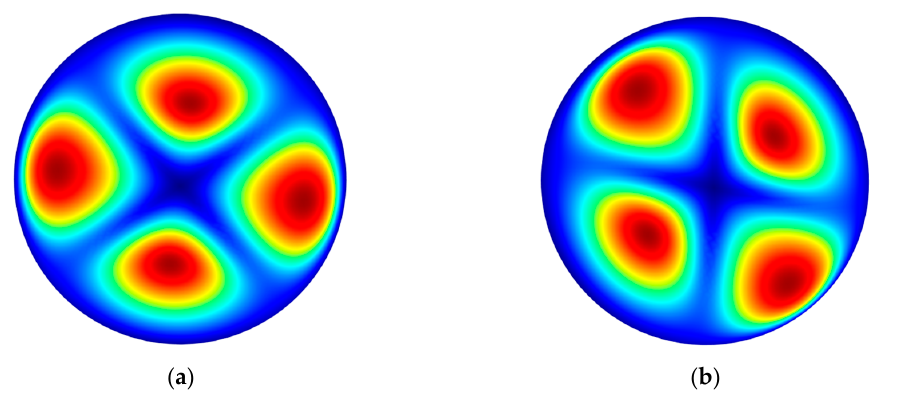
Figure 5. The simulated two degenerate four-node wineglass resonant mode ( n = 2) shapes of an HSR: ( a ) The four-node wineglass resonant mode shape; ( b ) The degenerate four-node wineglass resonant mode shape.